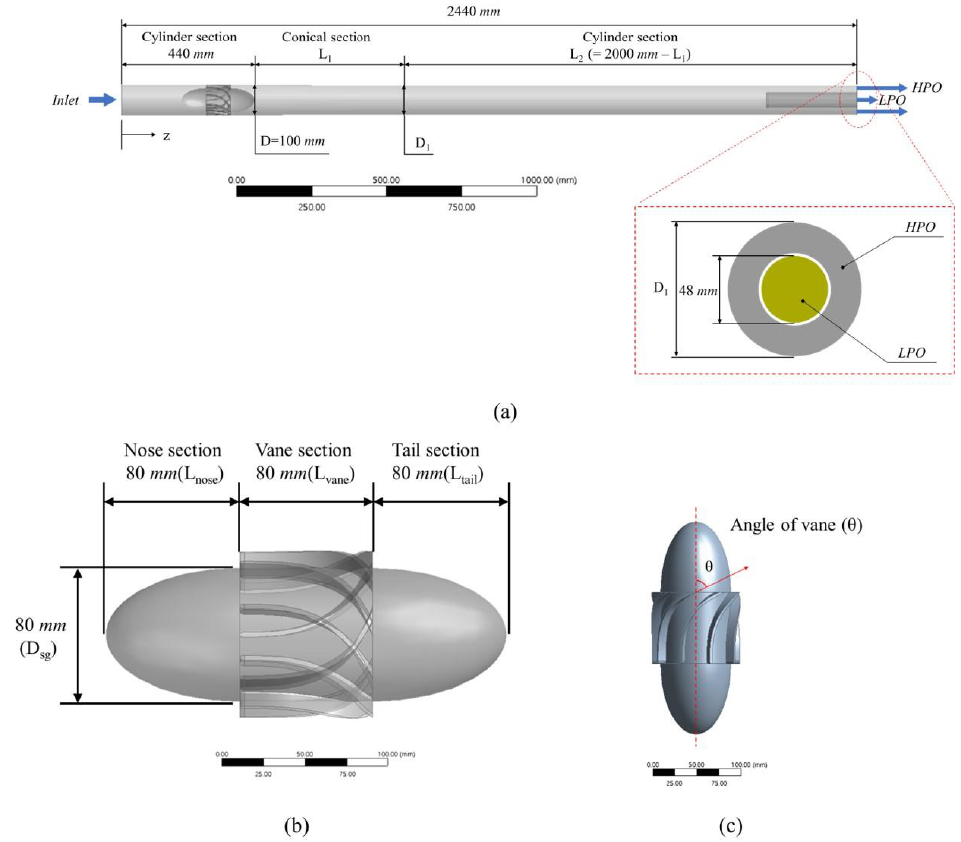
Figure 2. Schematic of the modeled in-line axial separator: ( a ) The schematic of the separator, ( b ) The schematic of the swirl generator, ( c ) The diagram of angle of vane.